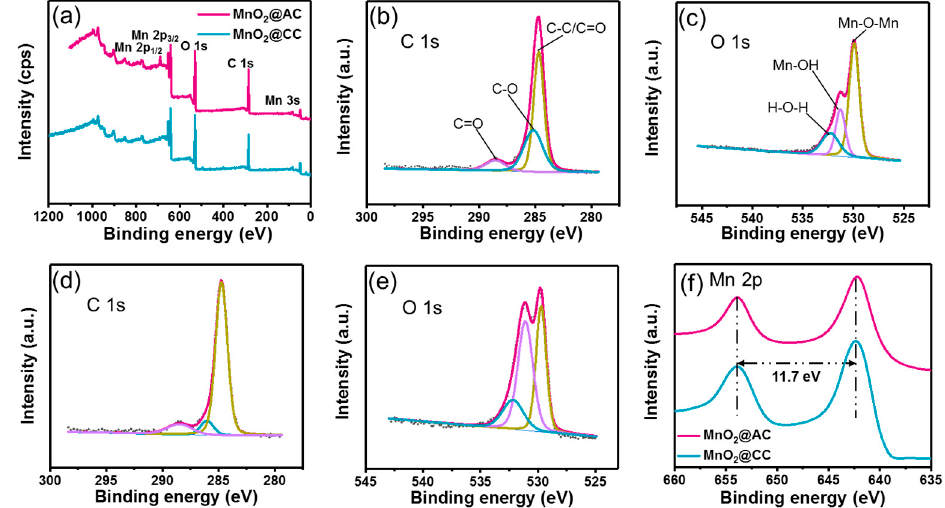
Figure 3. XPS spectra of of MnO 2 @AC and MnO 2 @CC. ( a ) Survey XPS spectra. High-resolution spectra of MnO 2 @AC: ( b ) C 1s peaks and ( c ) O 1s peaks. High-resolution spectra of MnO 2 @CC: ( d ) C 1s peaks